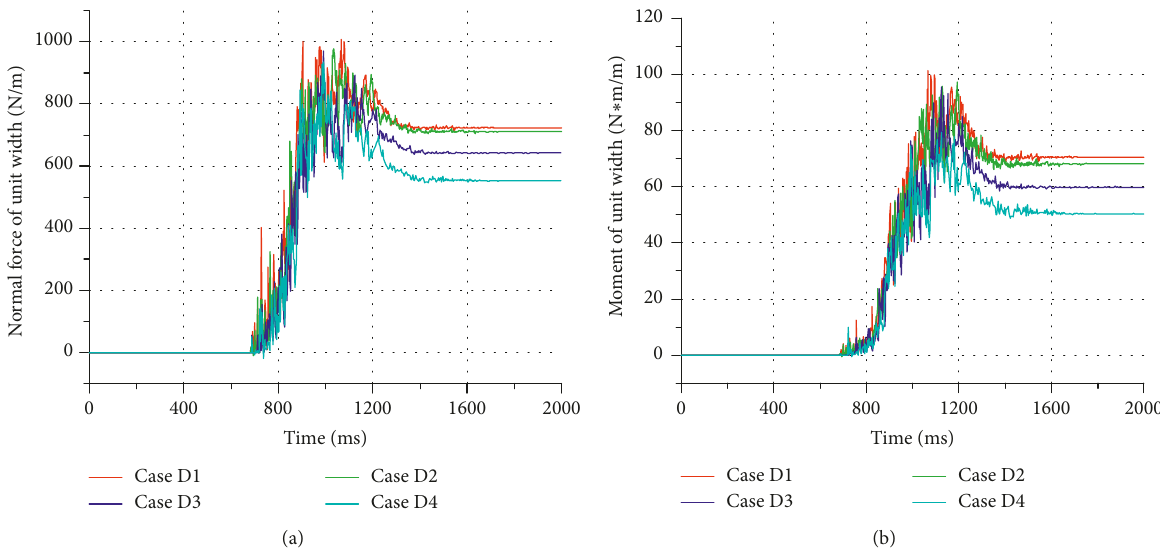
Figure 18: Time history of the impact of the graded granular flow on RNB with different mesh sizes: (a) time history of the unit-width normal force; (b) time history of the unit-width